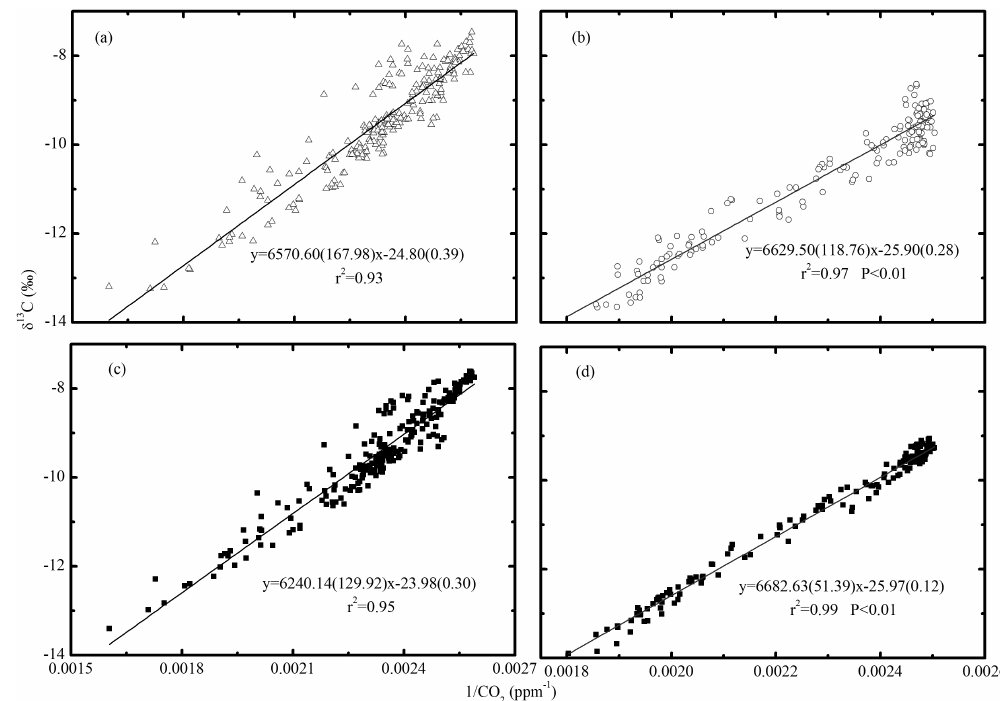
Figure 9. Keeling plot of the calibrated atmospheric δ 13 C against the reciprocal of the calibrated CO 2 concentration for the Pi- carro (a, b) G1101-i and (c, d) G2201-i analyzers. Panels (a) and (c) show plots measured before G1101-i was upgraded (G1101-i- original) (DOY 164–174), and (b) and (d) show plots measured after G1101-i was upgraded (G1101-i-upgraded) (DOY 348–356). Both daytime and nighttime data were